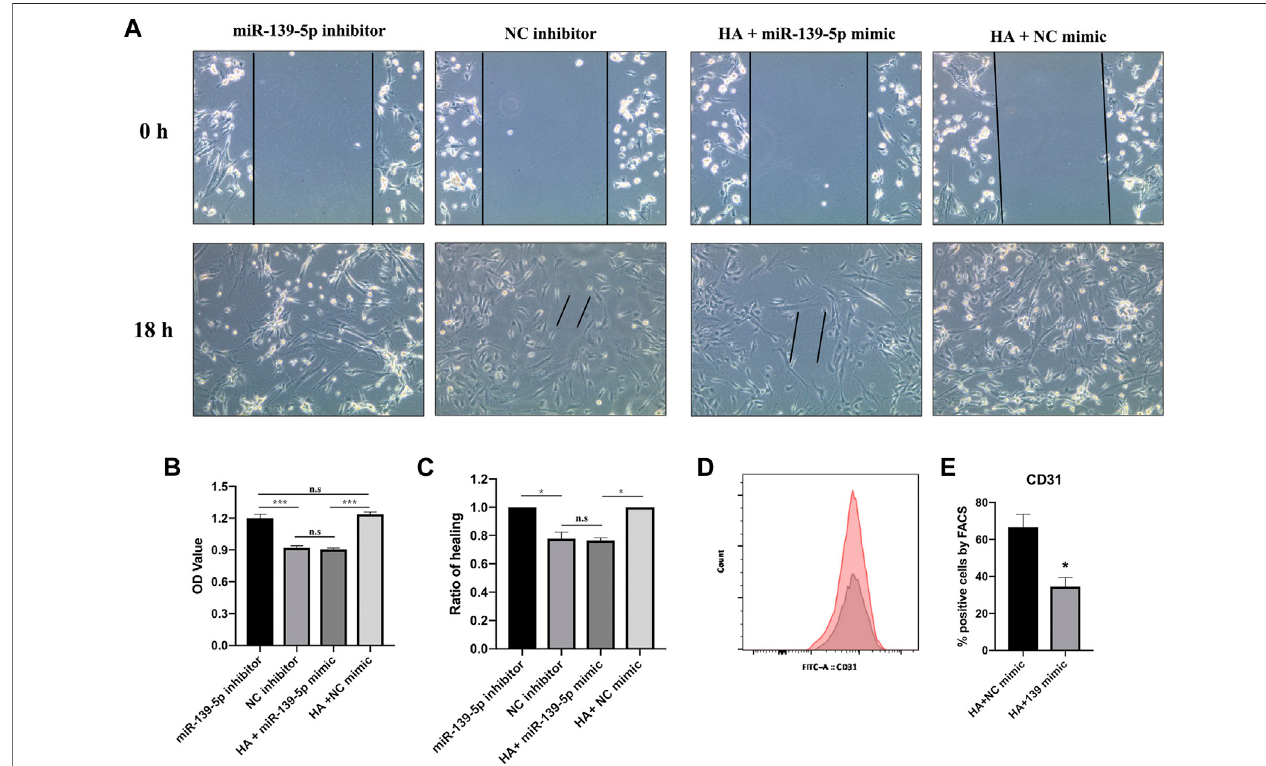
FIGURE6| HApromotesMSCs-ECFCs proliferation andmigrationthrough miR-139-5p. (A,C) . Woundhealingassayswereperformedtoassessthe migrationof MSCs-ECFCs transfected with miR-139-5p mimics and HA-MSCs-ECFCs transfected with miR-139-5p inhibitors, respectively. (B) . CCK8 assays were performed to assess the proliferation. (D) . Flow cytometry of CD31 sorted from HA-MSC-ECFC transfected with NC mimics (red) or miR-139-5p mimics (grey). (E) . Quanti fi cation of fl ow cytometry. ( n = 3 independent experiments, Error bars: mean ± SD. * p < 0.05, ** p < 0.01, *** p < 0.001).